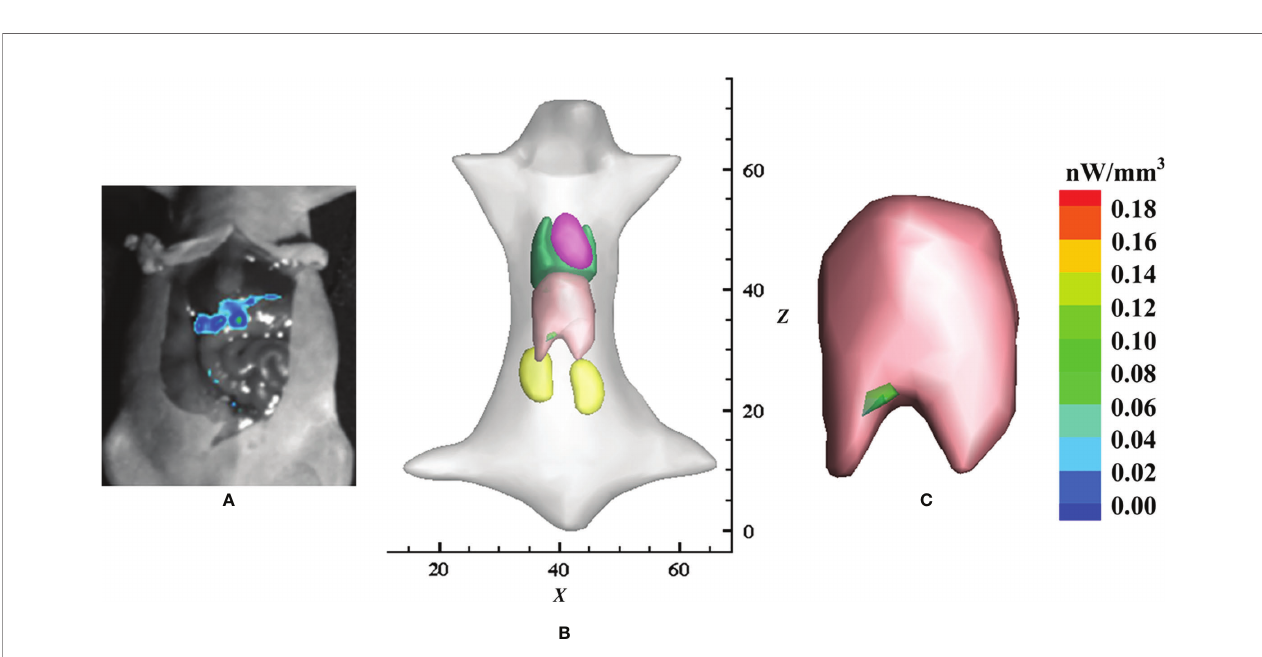
FIGURE 2 | Application of the adaptively alternative light transport model in longitudinal and quantitative monitoring of in situ gastric cancer. (A – D) Correspond to the time points of 2, 11, 21, and after 28 days of tumor formation. Adapted with permission from (20).